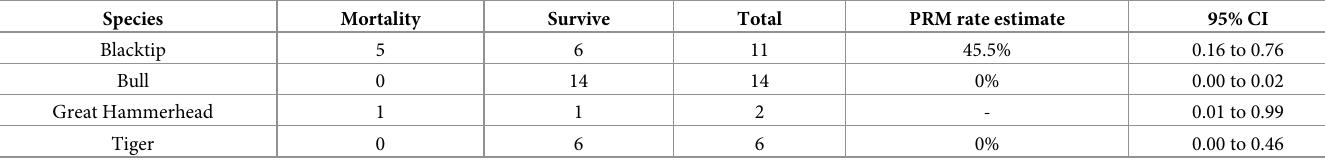
confidence intervals were calculated using the Clopper-Pearson exact method.